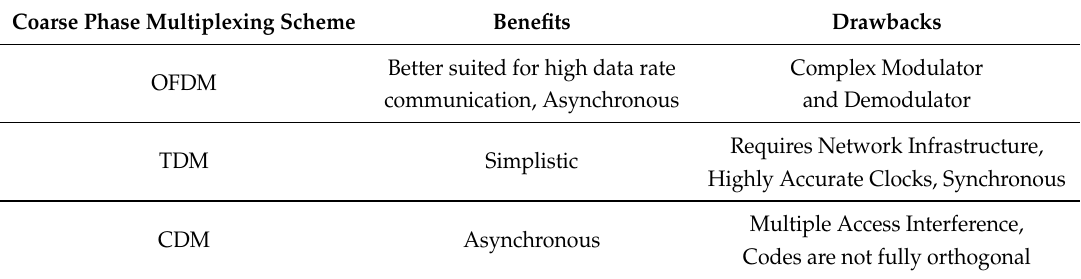
Table 2. Benefits and Drawbacks of Multiplexing Approaches during Coarse Phase Positioning.